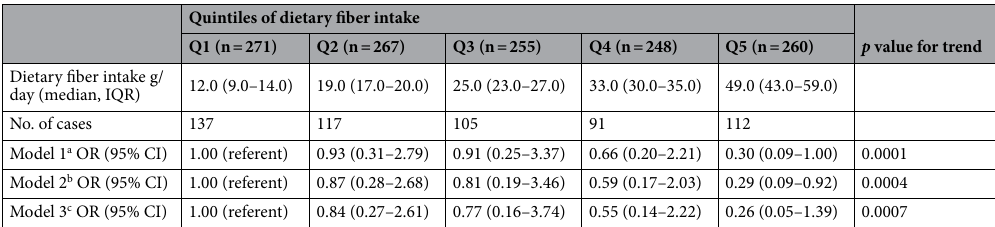
Table 2. Association of dietary fiber intake and metabolic syndrome in adult cancer survivors in the Korea National Health and Nutrition Examination Survey VI and VII (2013–2018). OR (95% CI) presented above are weighted according to the national adult population of the KNHANES (2013–2018). Q Quintile, IQR Interquartile range, OR Odds ratio, CI Confidence interval, KNHANES Korea National Health and Nutrition Examination Survey. a Adjusted for age, sex, and physical activity. b Adjusted for age, sex, physical activity, household income, education level, cigarette smoking, alcohol consumption. c Adjusted for age, sex, physical activity, household income, education level, cigarette smoking, alcohol consumption, and total energy intake.